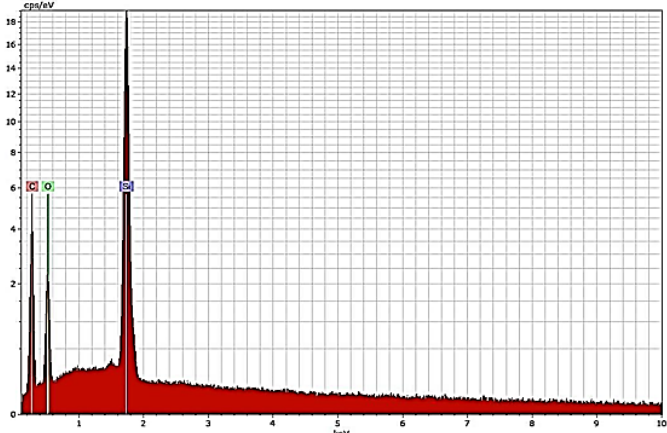
Figure A9. EDX spectrum of silicon-doped VOG (Sample S2) measured without Cu foil substrate.